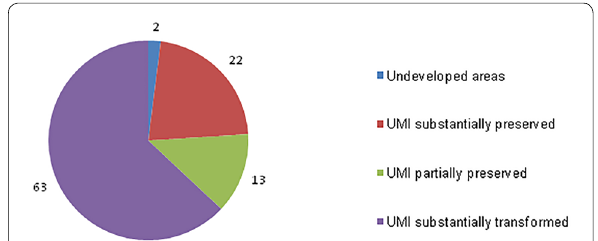
Fig. 1 Percentage distribution of UMI by historical landscape value judgment. Detailed Urban Plan